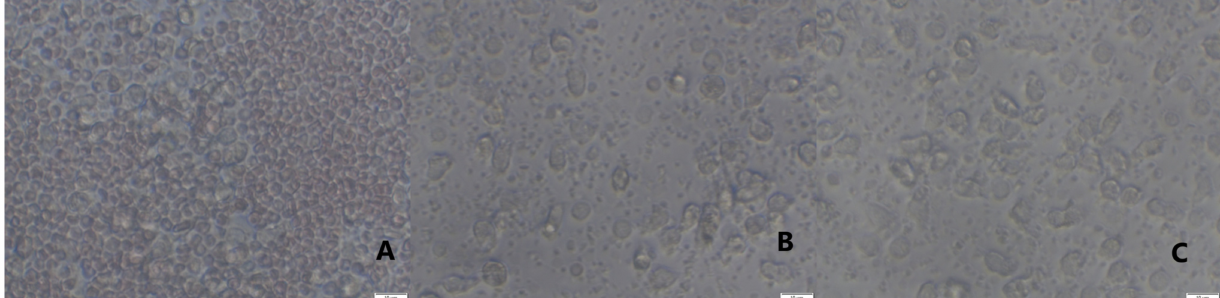
Figure 10. Representative phase contrast microscopical images. ( A ) Isolated neutrophils, ( B ) co-culture of activated PMNs with platelets after addition of PURE PRP, ( C ) co-culture of activated PMNs with platelets after addition of L-PRP. Original magnification × 40